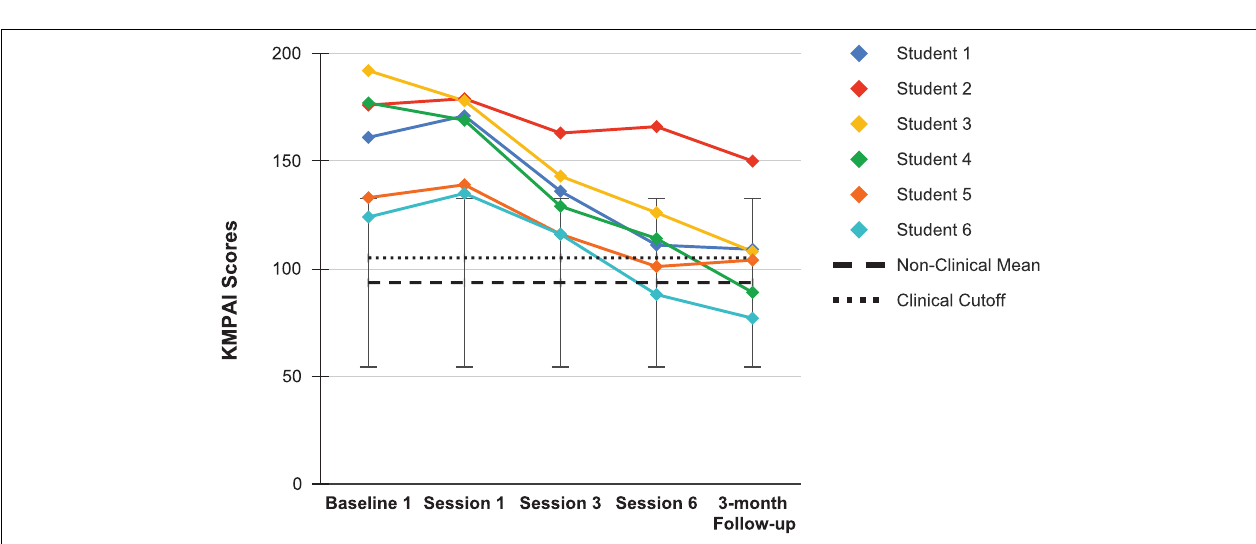
FIGURE 7 | PHLMS Acceptance subscale scores for seven vocal students (Juncos et al., 2017) showing scores from the baseline period to post-treatment, 1- and 3-month follow-up points, also with the non-clinical mean (30.19) and bars spanning one standard deviation up/down ( SD = 5.84; Cardaciotto et al., 2008).